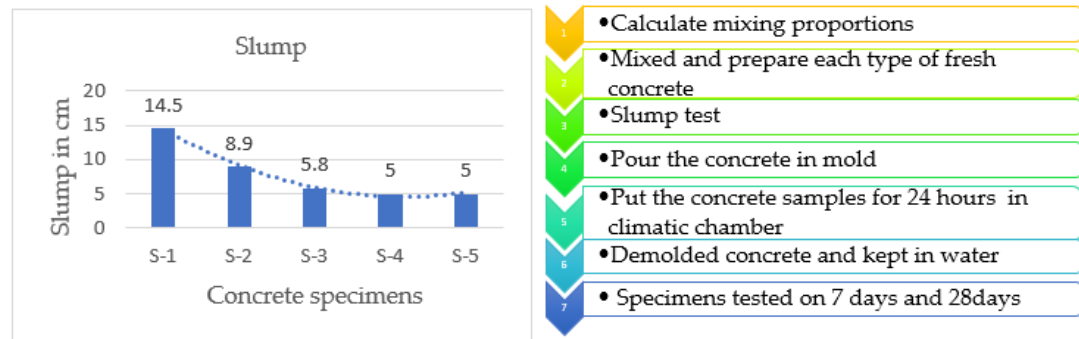
Figure 2. Slump value of concrete specimens and procedure of concrete production and tests.